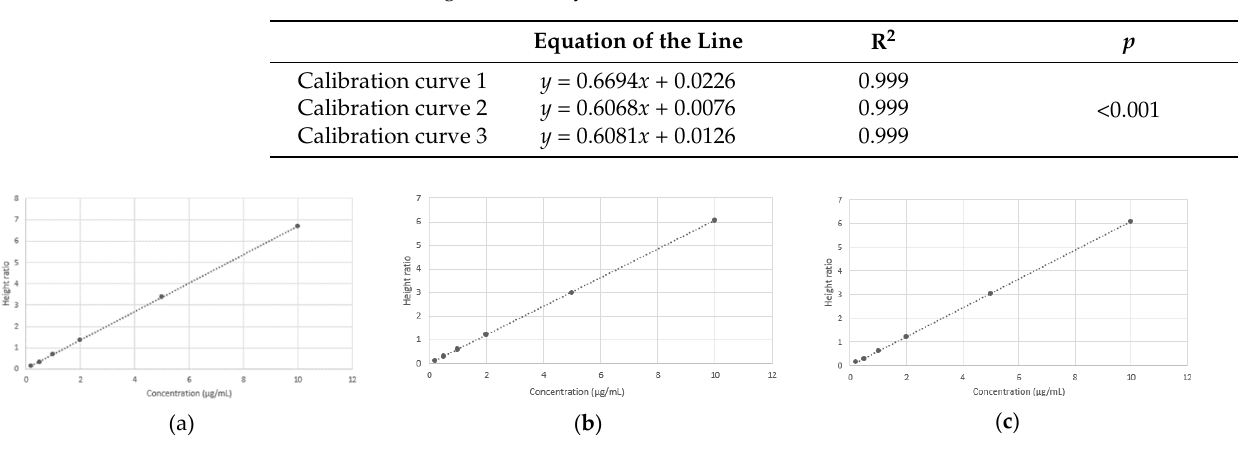
Table 2. Linear regression analysis of calibration curves.